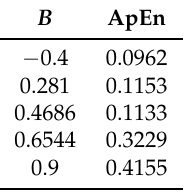
Table 1. Approximate entropy of the FoDS (7) for various values of B